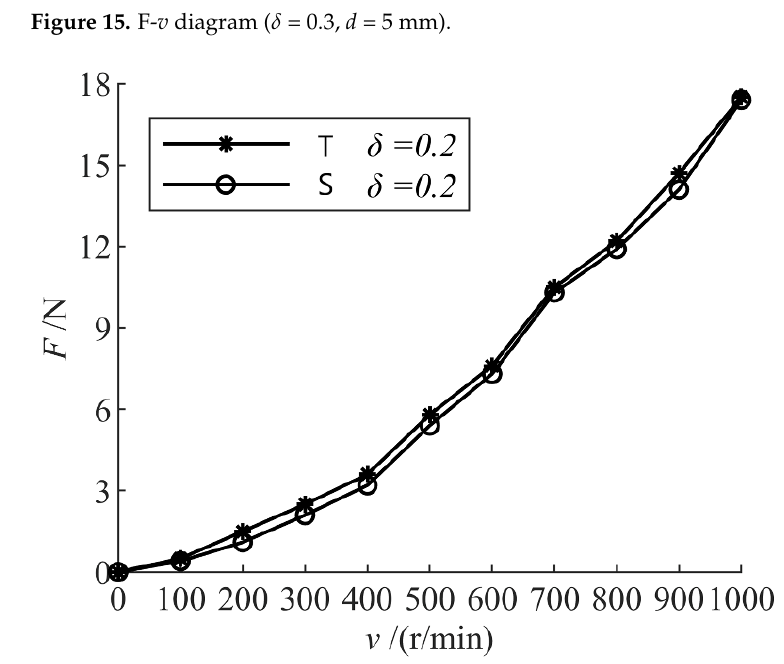
Figure 16. F- v diagram ( δ = 0.2, d = 5 mm).